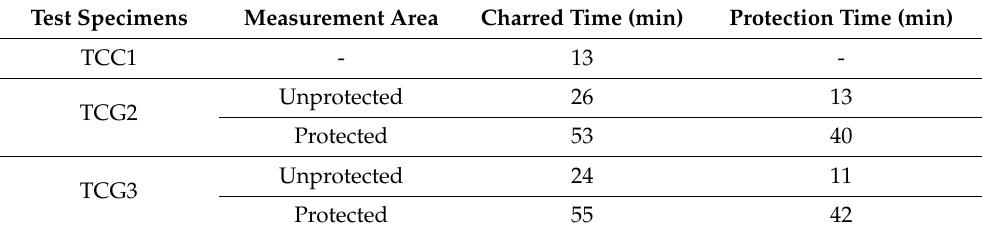
Table 3. Protection